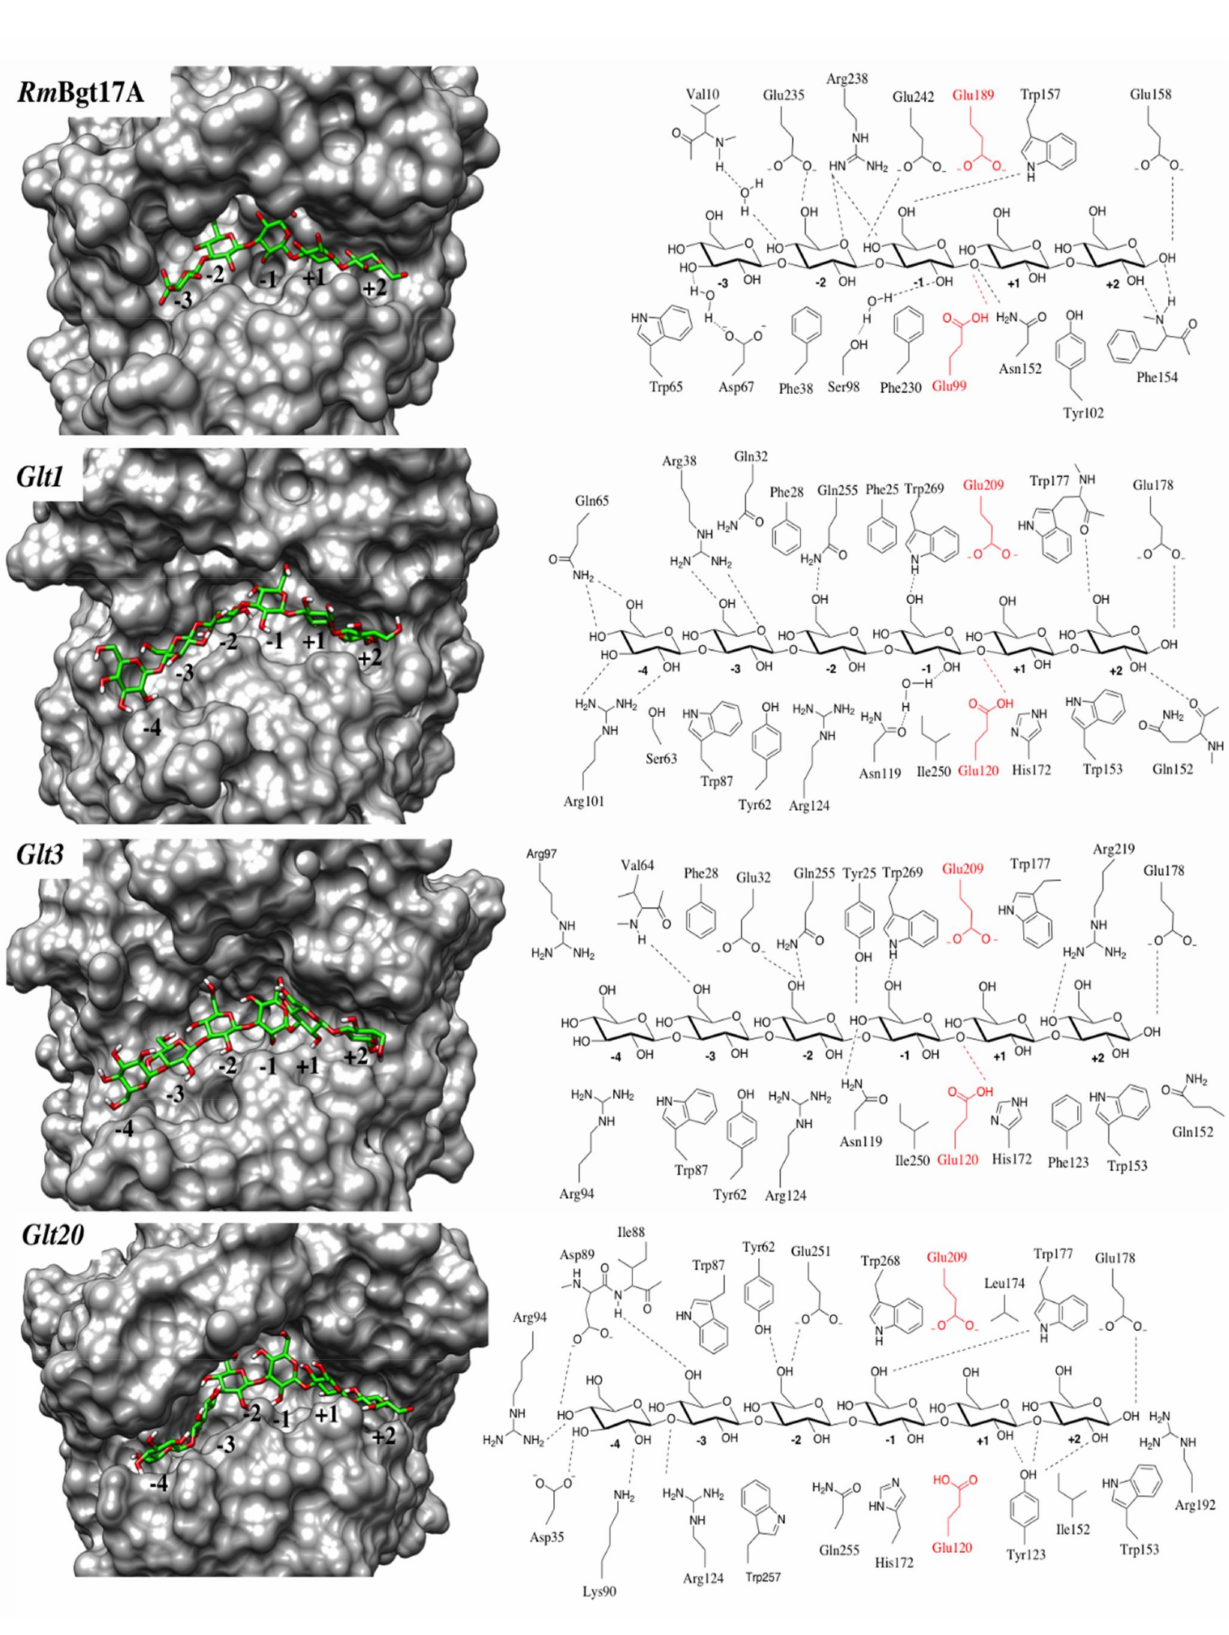
Figure 7. Enzyme–substrate complexes modeled in this work, compared with the co-crystallized complexes Rm Bgt17A— laminaritriose (4WTS)—laminaribiose (4WTR) [14]. Glt1, Glt3 and Glt20 have a putative additional subsite − 4. However, in Glt3, the predicted interactions in − 4 subsite are less clear, Arg94 and Arg97 are the closest amino acids to the glucose in the putative − 4